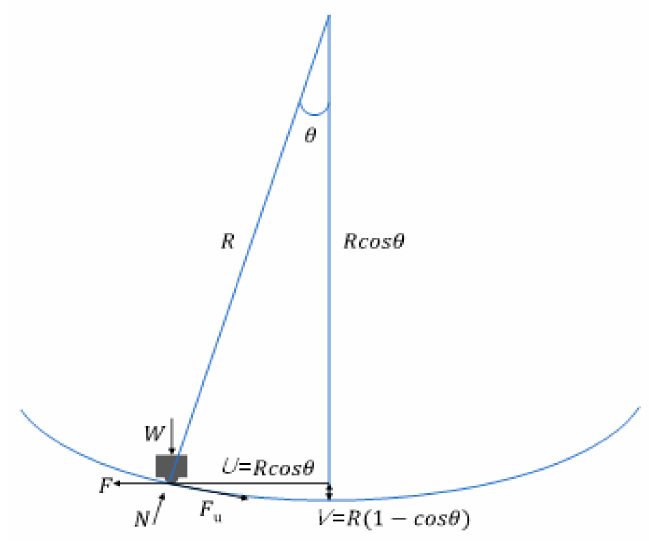
Figure 1. Typical principle of a friction pendulum system.